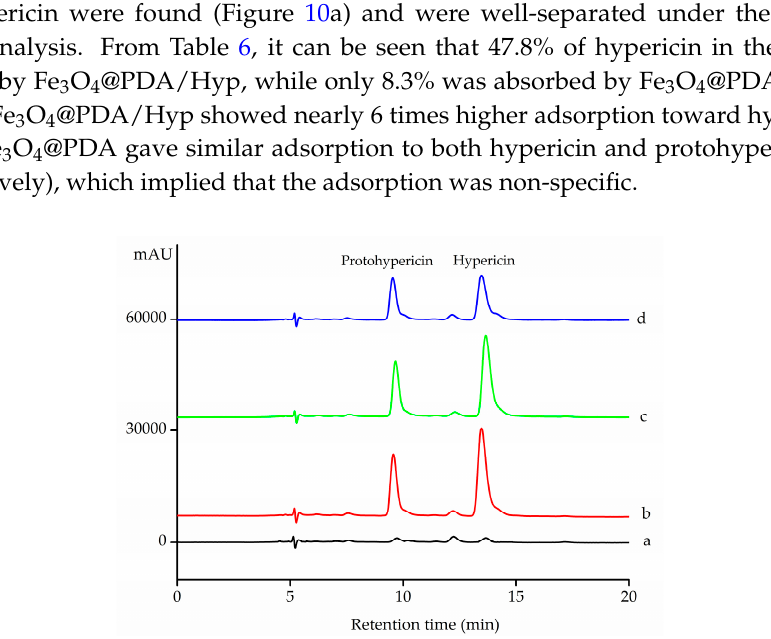
Figure 10. HPLC chromatograms. ( a ) the herb extract; ( b ) the mixture of the extract, hypericin and protohypericin before adsorption; ( c ) the supernatant after the adsorption of Fe 3 O 4 @PDA NSs; ( d ) the supernatant after the adsorption of Fe 3 O 4 @PDA/Hyp NSs. Table 6. The adsorption capacity of hypericin for hyperforin perforatum.